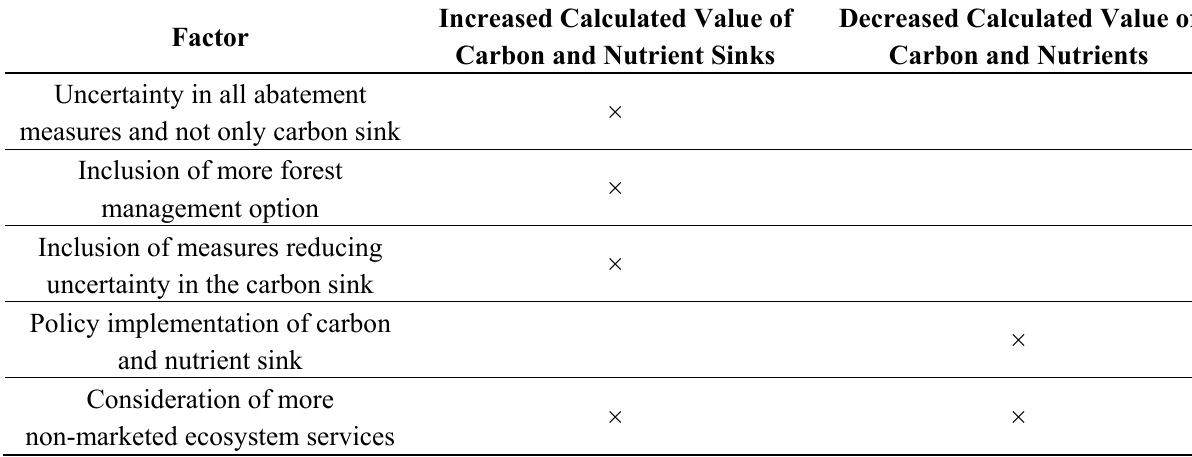
Table 2. Factors increasing or decreasing the calculated values of forest carbon sequestration and nutrient recycling, where × denotes the direction of